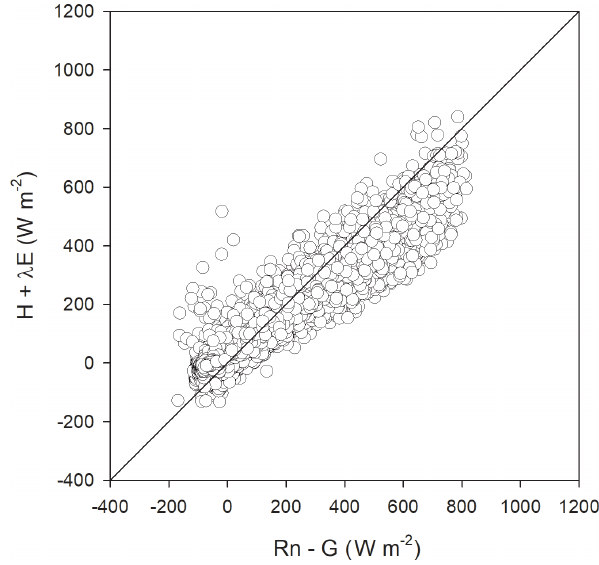
Figure 5. Closure of the surface energy balance from eddy covari- ance measurements averaged at 30min between the turbulent fluxes ( H + λE ) and available fluxes (Rn-G). Data are from 30 March 2017 to 22 August 2018 at the Bernal site. The regression was y = 23 . 02 + 0 . 72 × , with adjusted r 2 = 0 . 92. The diagonal line rep- resents the 1 : 1 relation.